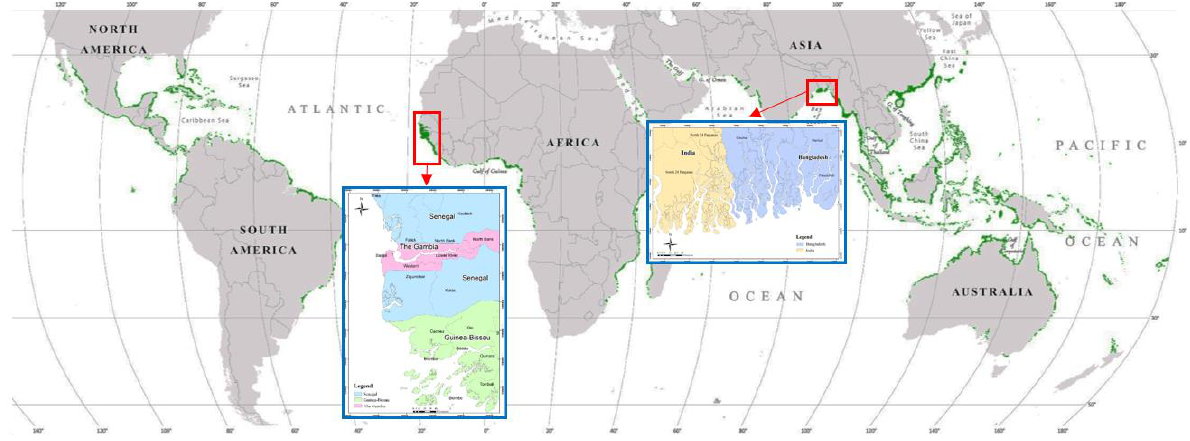
Figure 1. Two sites of study in West and Central Africa and Sundarbans delta.